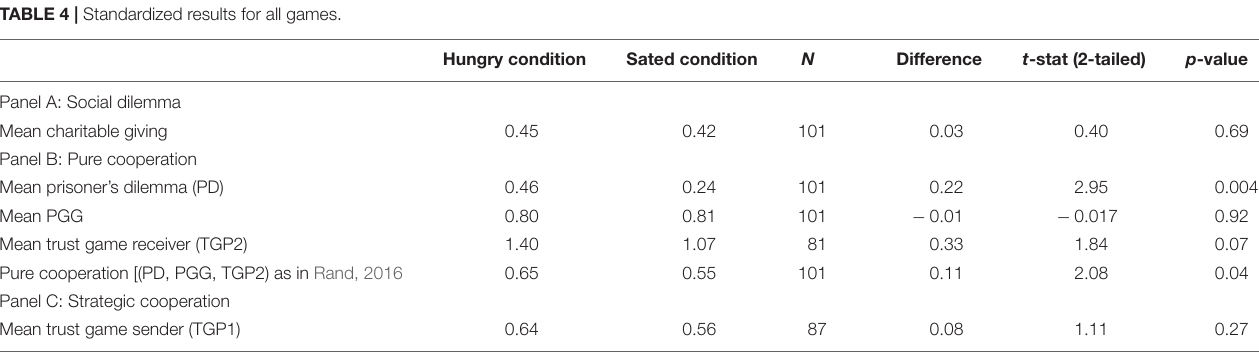
TABLE 4 | Standardized results for all games.